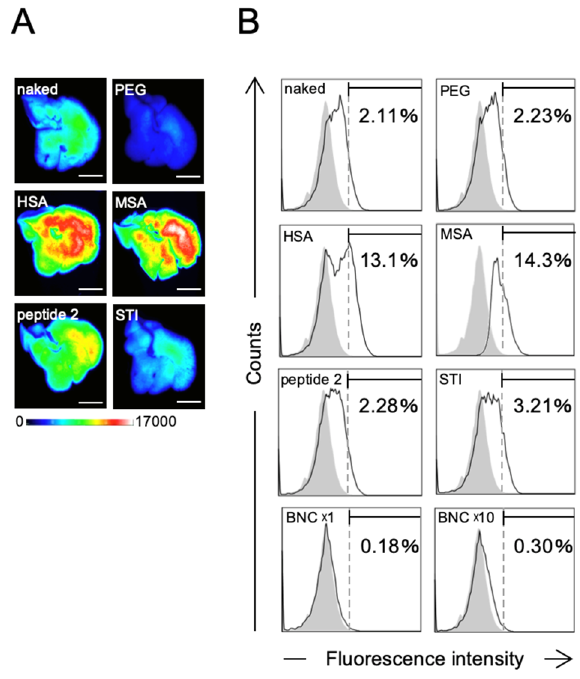
Figure 7. Evaluation of hepatotropic properties of microspheres and BNCs. ( A ) In vivo uptake of fluorophore-labeled microspheres by mouse livers. About 100 μ g of NYO-labeled microspheres (naked, PEG-modified, HSA-modified, MSA-modified, peptide 2-modified, or STI-modified) were administrated intravenously into each mouse. After 10 min, livers were isolated and subjected to the in vivo imaging analysis. The color bar shows NYO-derived fluorescence intensity. Bar, 1 cm. ( B ) After opsonization of Cy3-labeled BNCs and NYO-labeled microspheres (naked, PEG-modified, HSA-modified, MSA-modified, peptide 2-modified, or STI-modified), about 5 × 10 4 mouse primary hepatocytes were incubated with NYO-labeled microspheres (about 1 × 10 9 particles) or Cy3-labeled BNCs (about 1 × 10 9 or 1 × 10 10 particles) at 37 °C for 30 min and then subjected to the FACS analysis. Distributions of microspheres and BNCs in hepatocytes were indicated as open histograms. Controls (untreated hepatocytes) were indicated as shaded histograms. The percentages (%) of NYO-labeled or Cy3-labeled hepatocytes were presented as numbers.